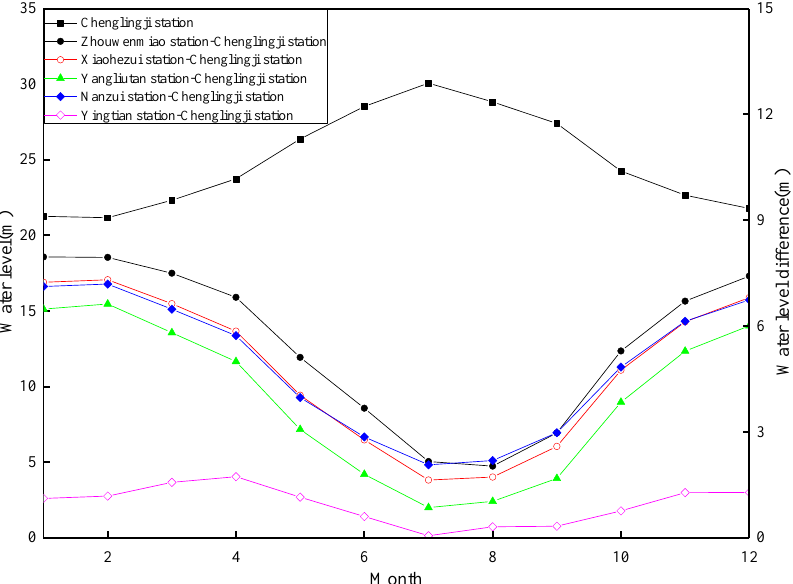
Figure 5. Water level difference between Chenglingji and other hydrological stations.